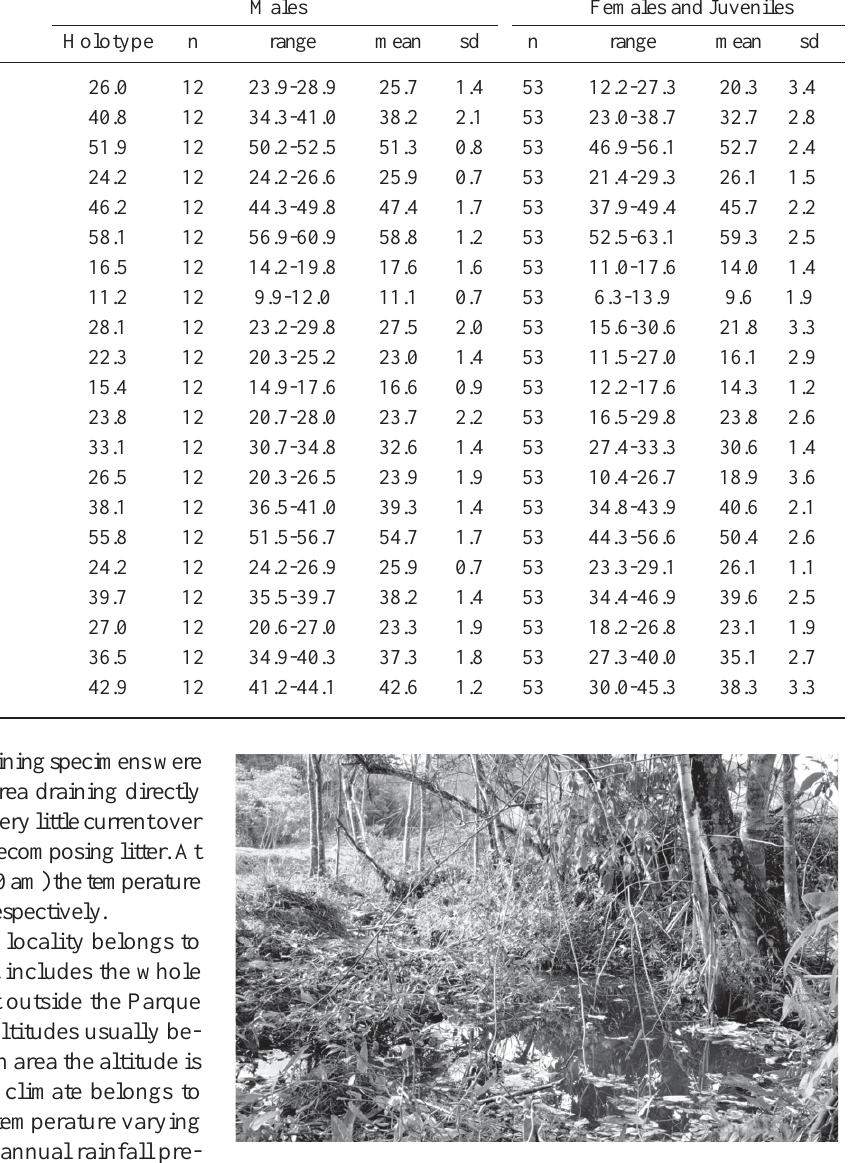
Fig. 9 . Type locality of Lophiobrycon weitzmani . Brazil, Minas Gerais, rio Grande basin, Município de Delfinópolis,